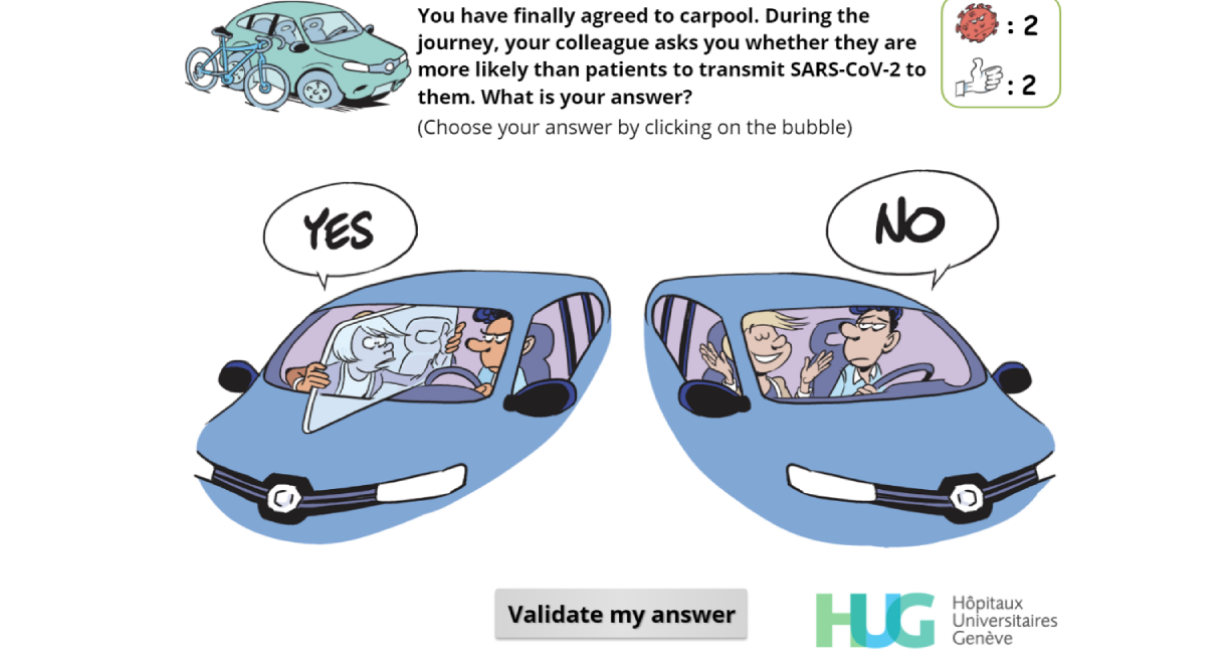
Figure 11. Simple-choice interaction. The player has not selected any option and cannot click on “Validate my answer” for the moment.